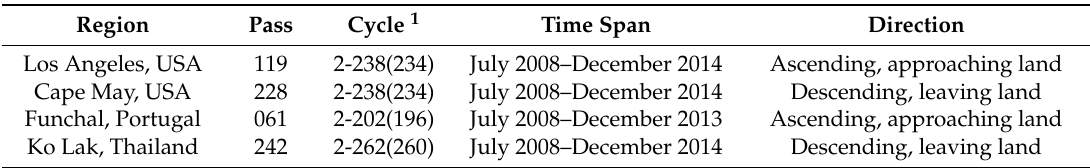
Table 1. Brief introduction to Jason-2 data in each study region.